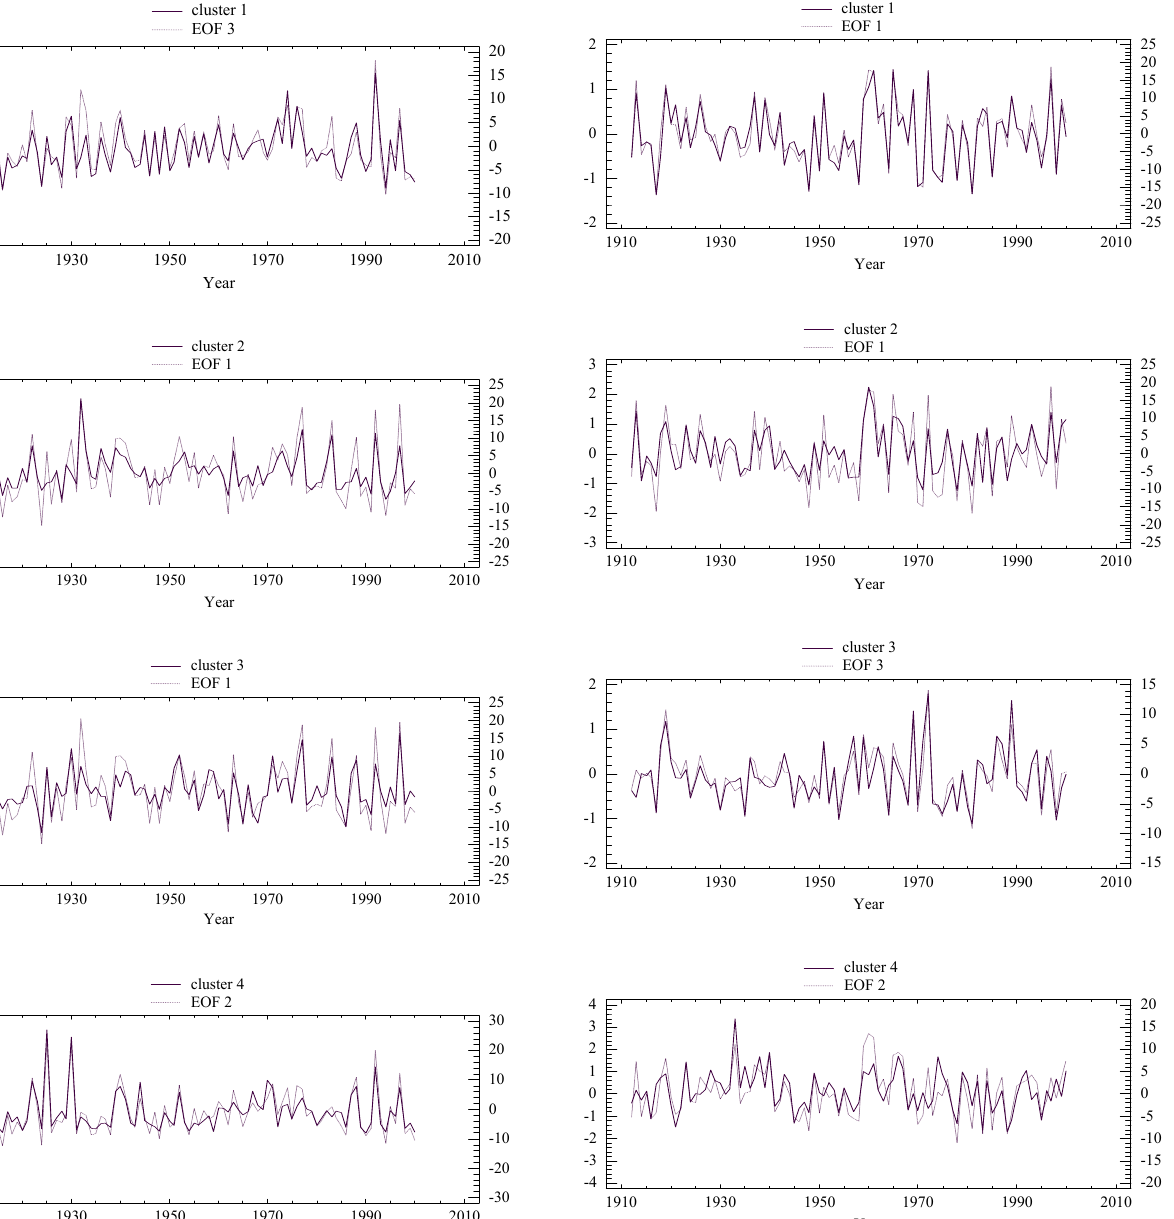
Fig. 12. As Fig. 10, for summer.